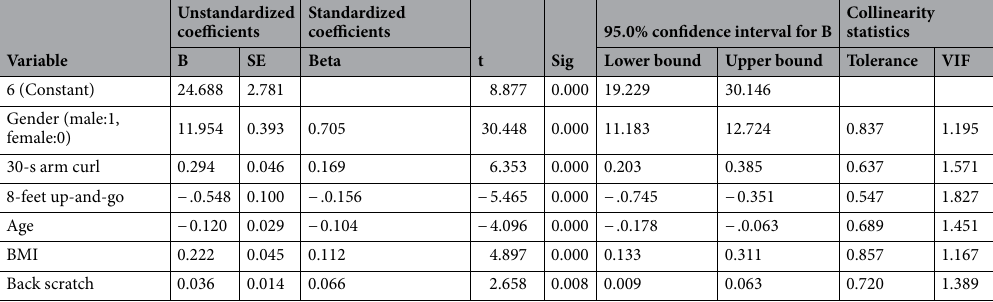
Table 3. Handgrip strength analyzed using a stepwise multiple linear regression model. N = 2,130; adjusted R-square, 0.593.